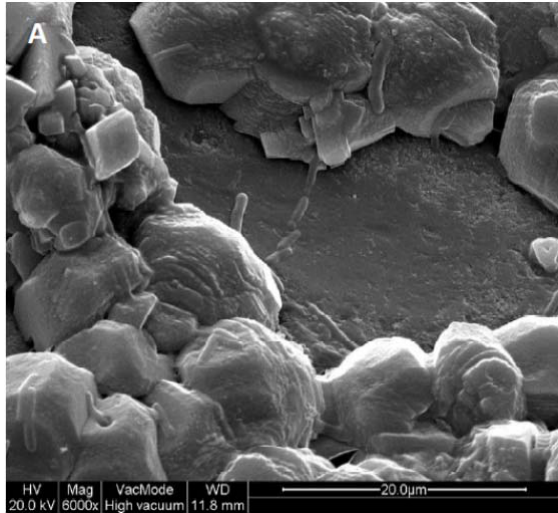
Figure 1. SEM micrograph of bacterial CaCO 3 precipitation on concrete samples (courtesy of Lien Standaert).